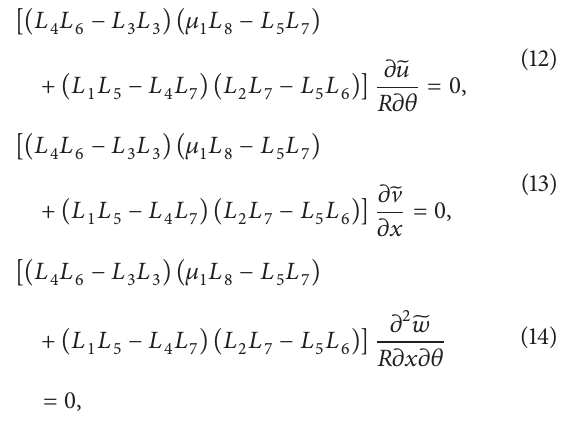
𝑁 𝑥 and 𝑥𝜃 denote the in-plane normal force and in-plane shear force. 𝑀 𝑥 and 𝑀 𝑥𝜃 represent the bending moment and torsional moment. 𝑄 𝑥𝑧 denotes the out-of-plane shear force. = 𝑁 + 𝑀 /𝑅 and 𝑉 = 𝑄 + 𝜕𝑀 /𝑅𝜕𝜃 , respectively, 𝐹 𝑥𝜃 𝑥𝜃 𝑥𝜃 𝑥𝑧 𝑥𝑧 𝑥𝜃 represent the in-plane and out-of-plane resultant shear